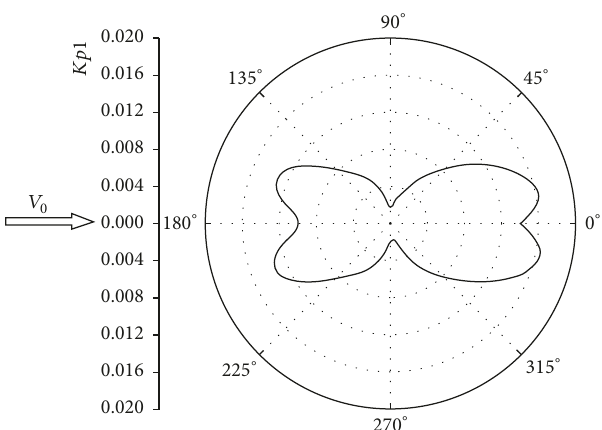
Figure 19: Two-dimensional distribution of the fluctuating pressure of single propeller.